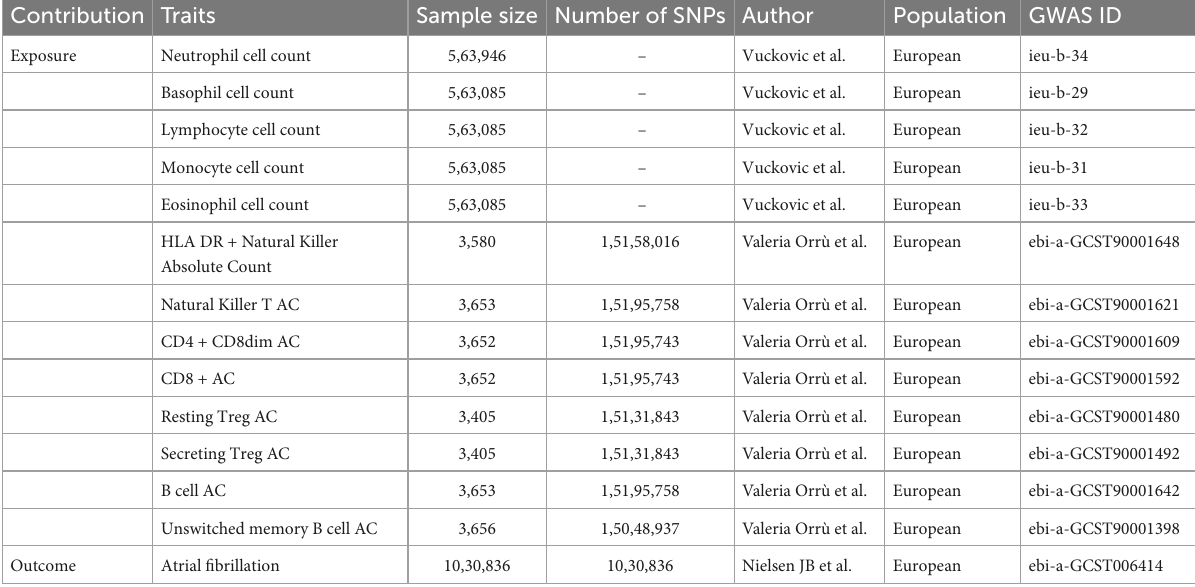
TABLE 1 Description of included trails in the